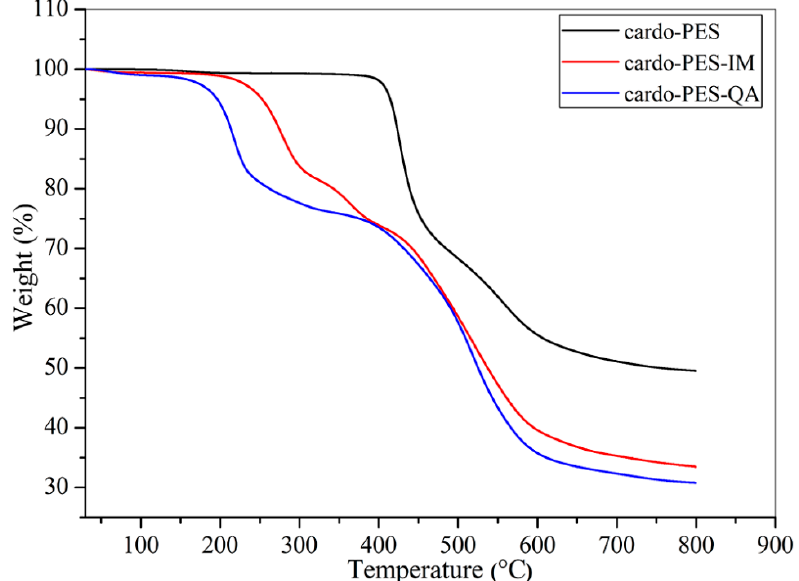
Figure 5. TGA thermograms of the multiblock copolymers.